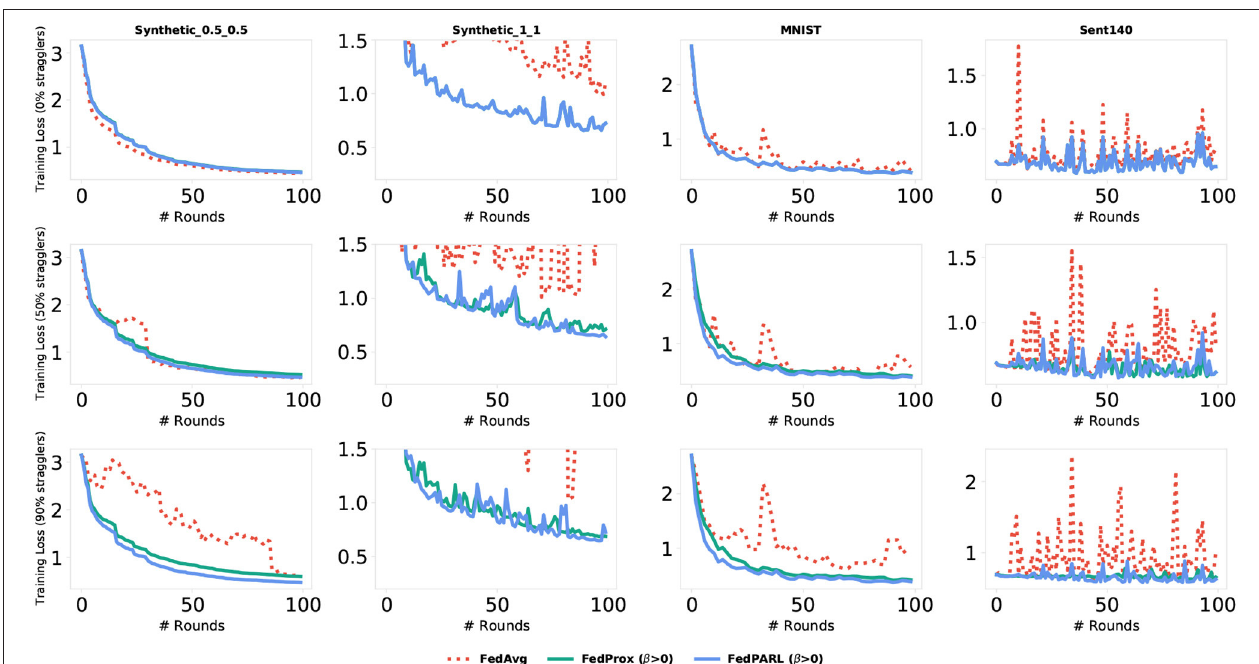
FIGURE 12 | Comparison of training loss of our proposed FedPARL framework (considering β > 1) with FedAvg and FedProx in the presence of stragglers.